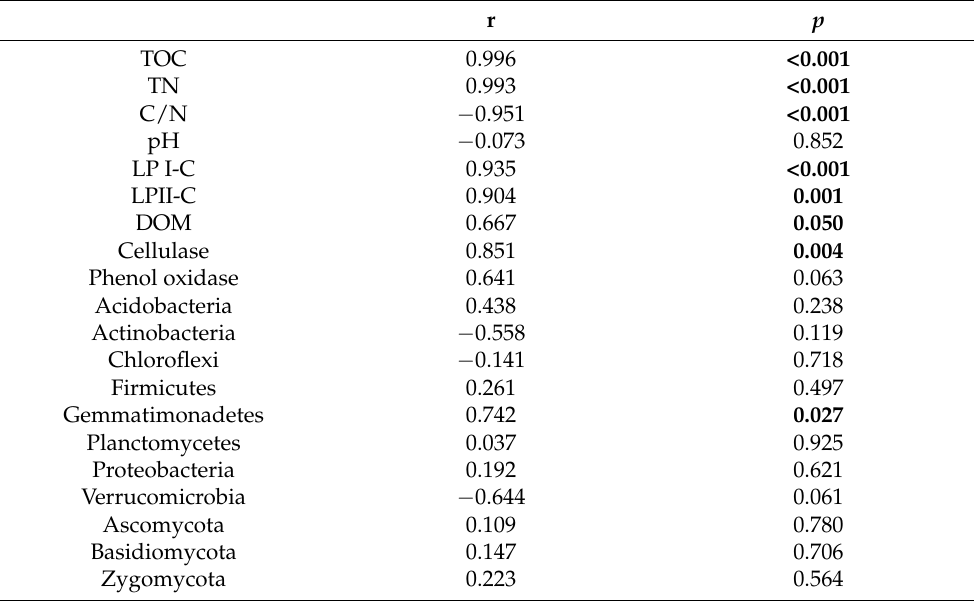
Table 5. Pearson’s correlation between soil organic matter mineralization and soil properties, organic carbon components as well as microbial community compositions. Significant difference at p < 0.05 is given in